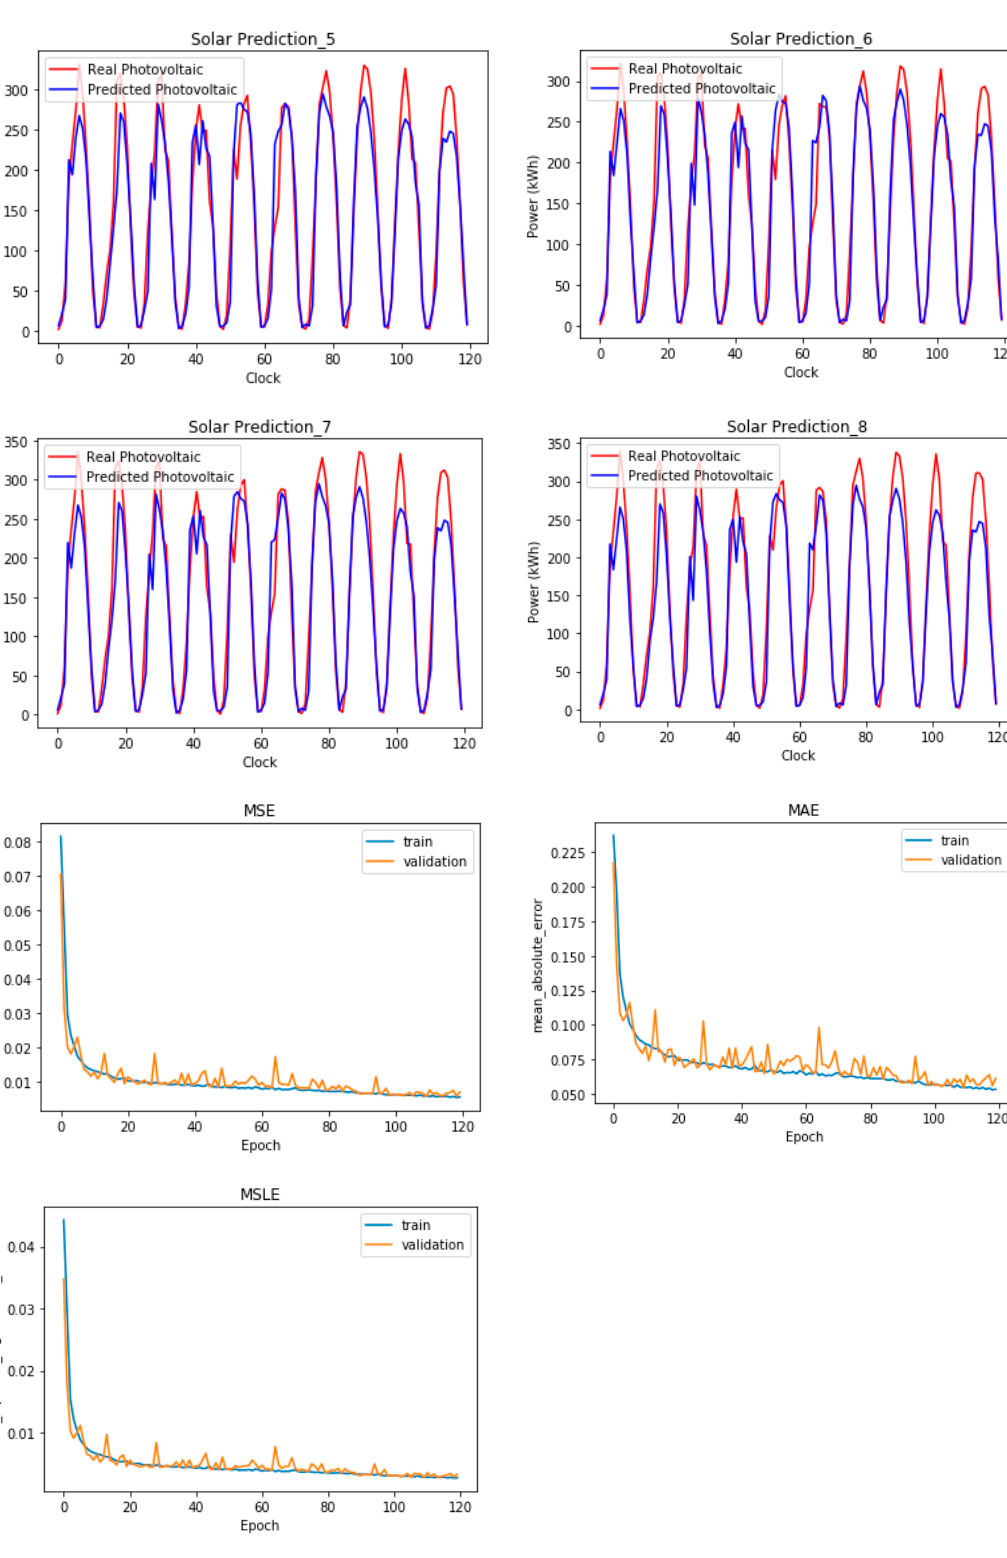
Figure 6. Multiple inverters and model predictions with the same A-11 feature variable information (BiLSTM).